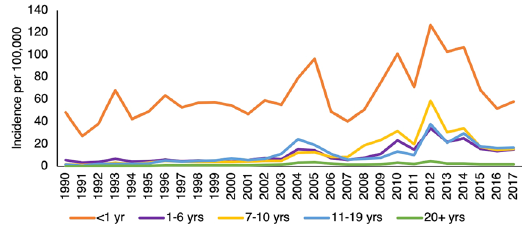
Figure 1. U.S. time-series showing pertussis incidence per 100,000 people categorized by age group for 1990–2017. After introduction of an acellular vaccine, there was an increase in incidence among school age and adolescent age groups. Data from the National Notifiable Diseases Surveillance System 9